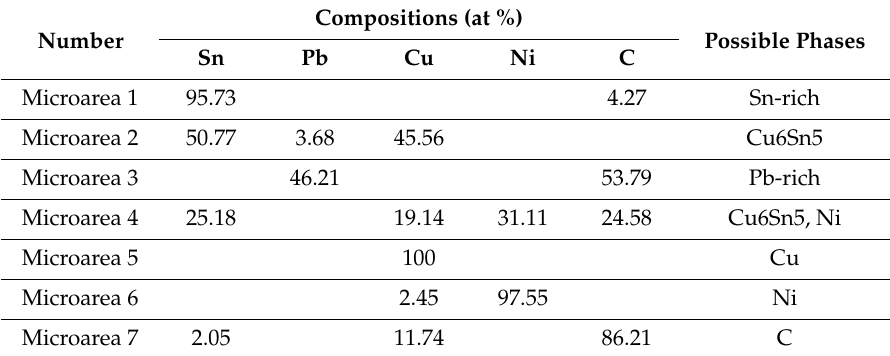
Table 6. Chemical composition of microareas 1–5 indicated in Figure 8a,b.